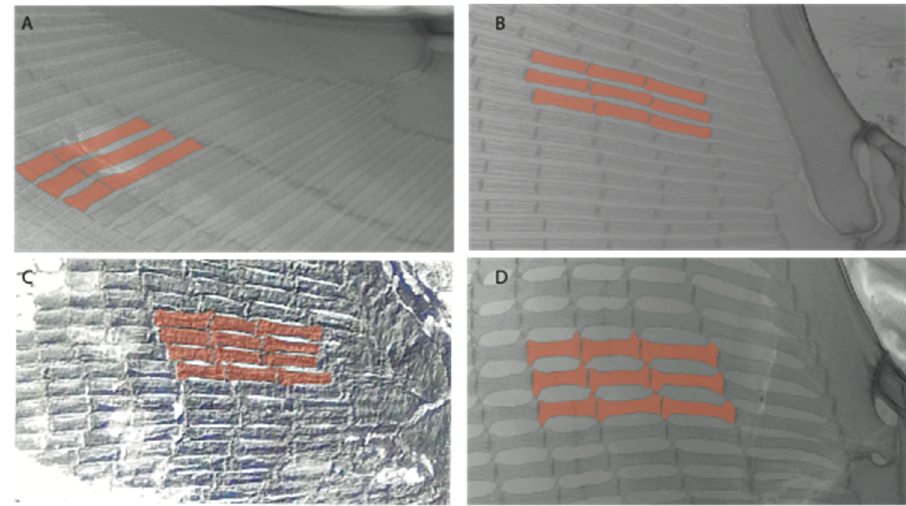
Figure 46. Dorsal view of a portion of the pectoral fins with radials highlighted in orange showing the cross-bracing articulation between adjacent radials. State (0): ( A ) Pseudobatos percellens (CAS SU11828-29); ( B ) Urobatis halleri (CAS SU2948). State (1): ( C ) † Britobatos primarmatus (MNHN 1946.18.94); ( D ) Gymnura marmorata (CAS SU1158).